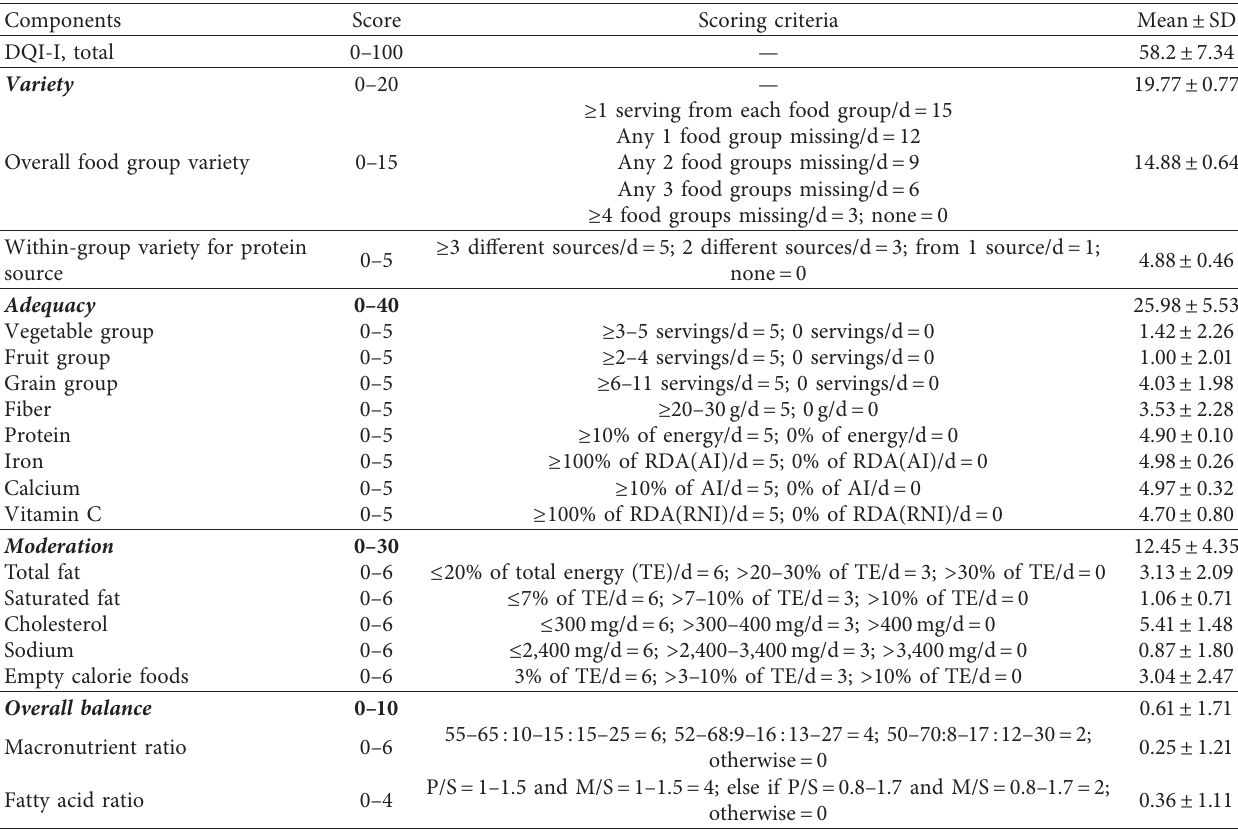
Table 3: DQI-International (DQI-I) components and criteria used for maximum score and zero score ( n � 235).